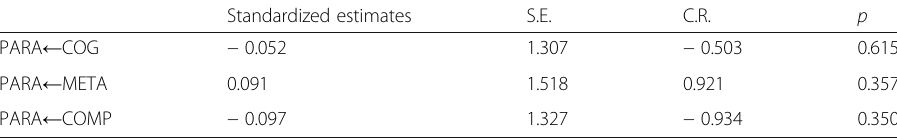
Table 8 Relationship between test takers ’ strategy use and paraphrasing